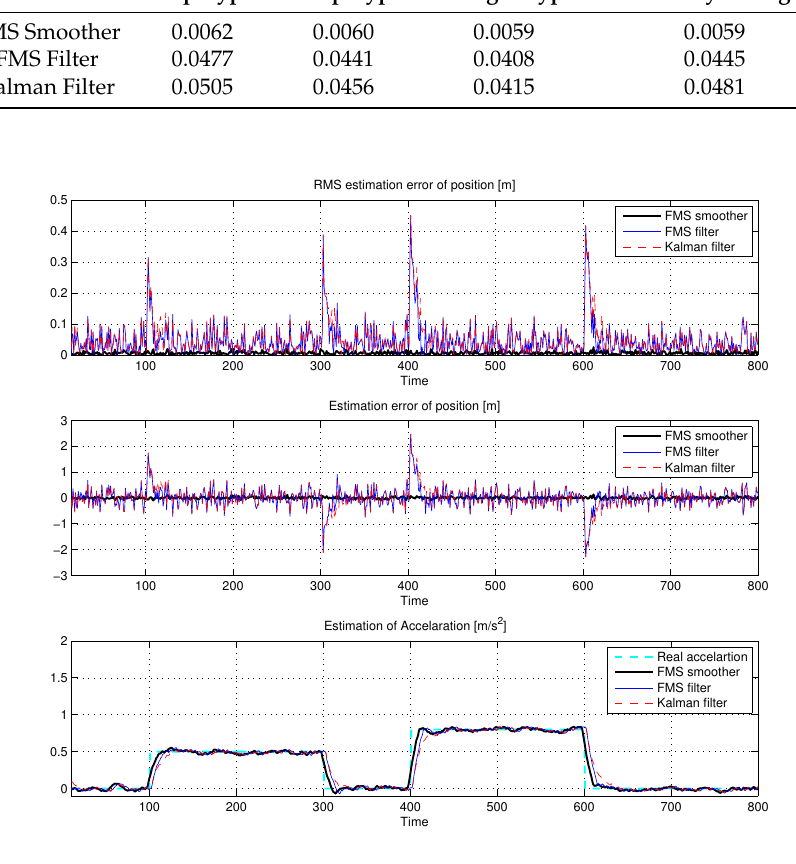
Figure 1. Simulation result for suddenly changing